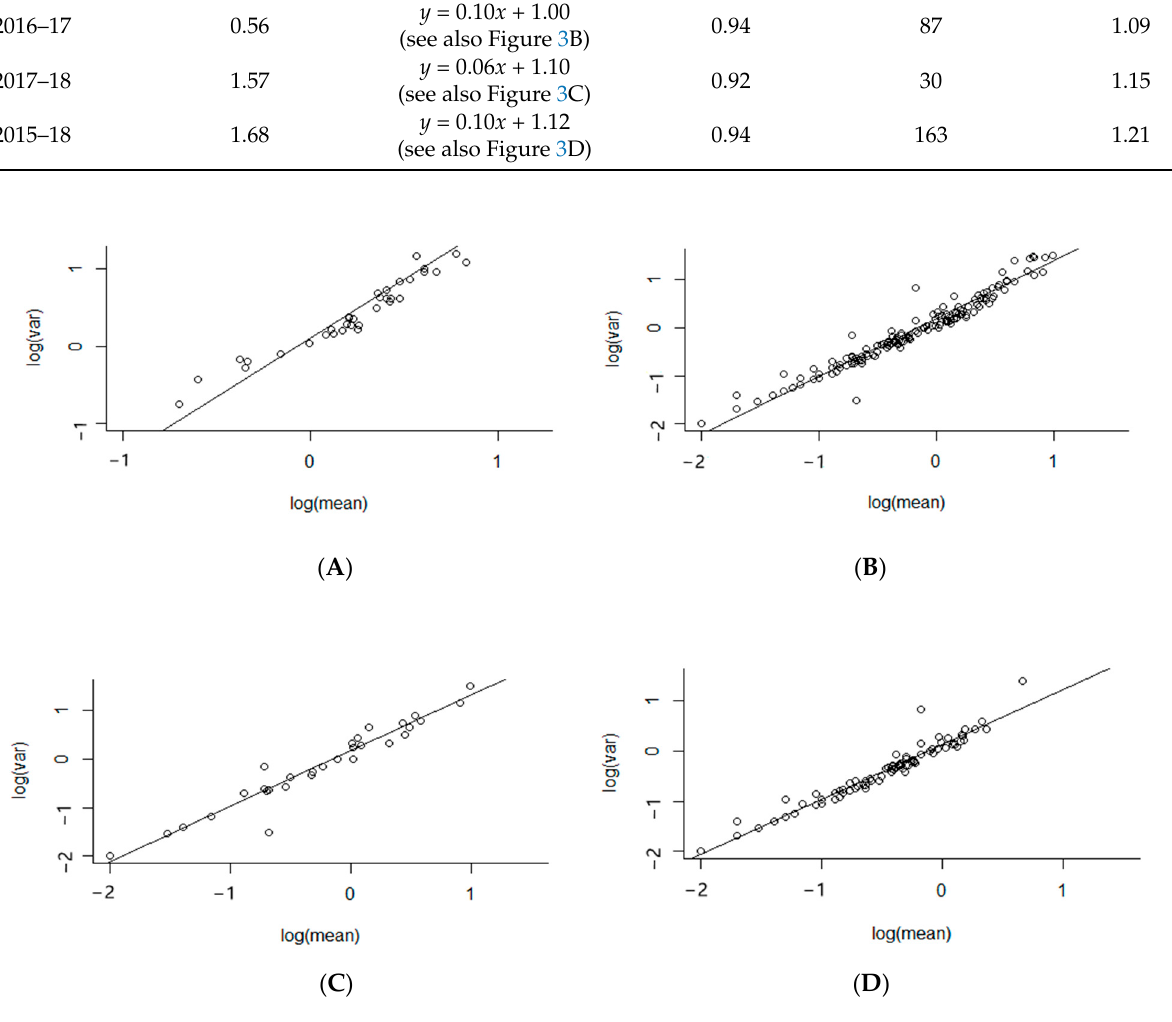
Figure 3. The relationship between log (variance) and log (mean) number of slugs per trap recorded in the 10 × 10 grid of refuge traps, set within a rectangular 1ha plot in each field assessed in ( A ) 2015–16, ( B ) 2016–17, ( C ) 2017–18 and ( D ) all three years. Each point on the graphs represents one assessment date in one field.